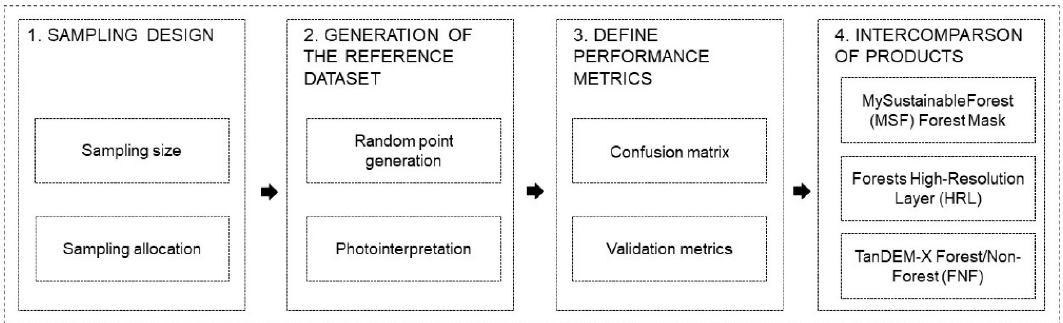
Figure 2. Methods used to validate the forest mask products.